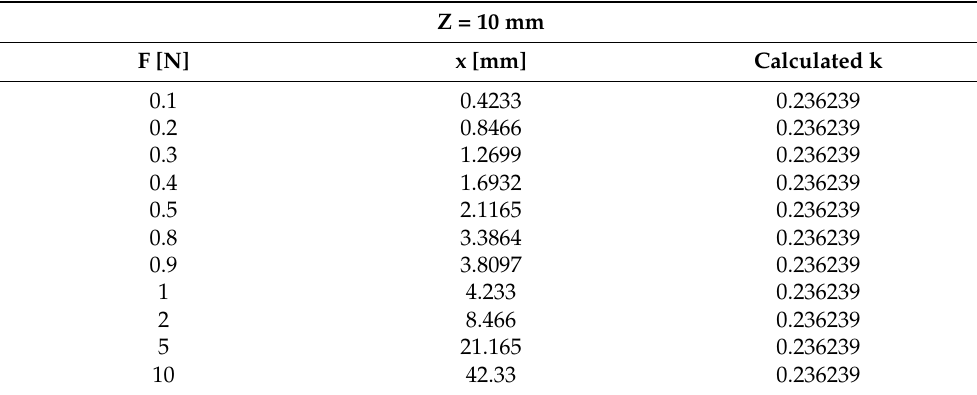
Table 2. Simulation values for z = 10 mm and force F from 0.1 to 10 N.